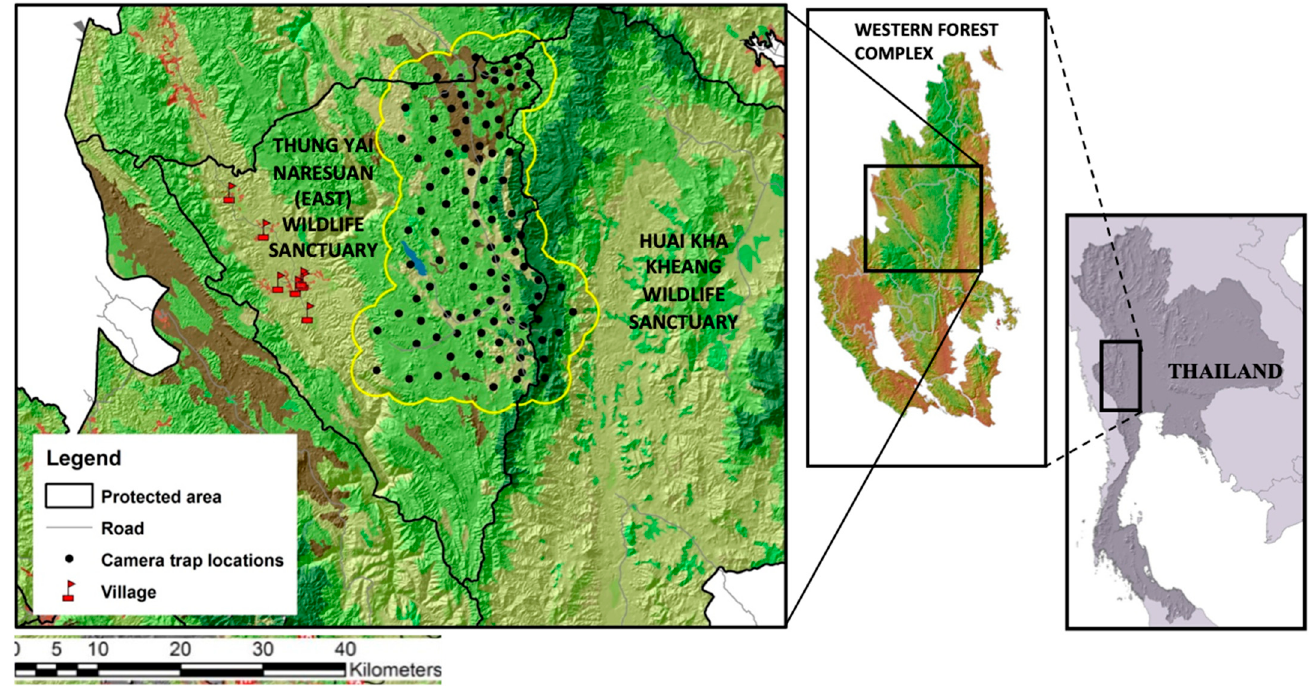
Figure 1. Location of camera trapping array (outlined in yellow) in the Thung Yai Naresuan (East) Wildlife Sanctuary within the Western Forest Complex of Thailand.